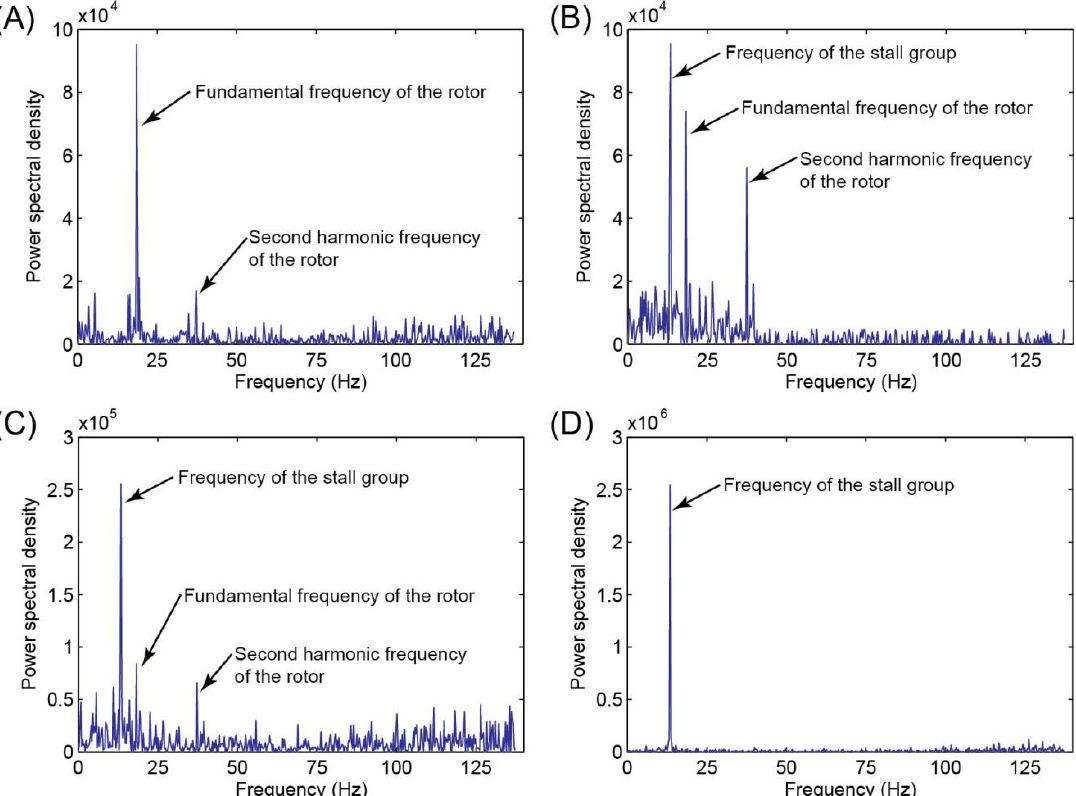
Figure 2. The spectrum diagram of pressure signal (from sensor #2) in the development of a rotation stall. From ( A ) to ( D ), the flow rate was gradually decreased by adjusting the throttling cone, corresponding a discharge coefficient ( ) of 0.172, 0.154, 0.151, 0.147, respectively. Starting from ( B ), the rotation stall occurred and developed from a weak stall in ( B ) into a strong stall cell in ( C ) and ( D